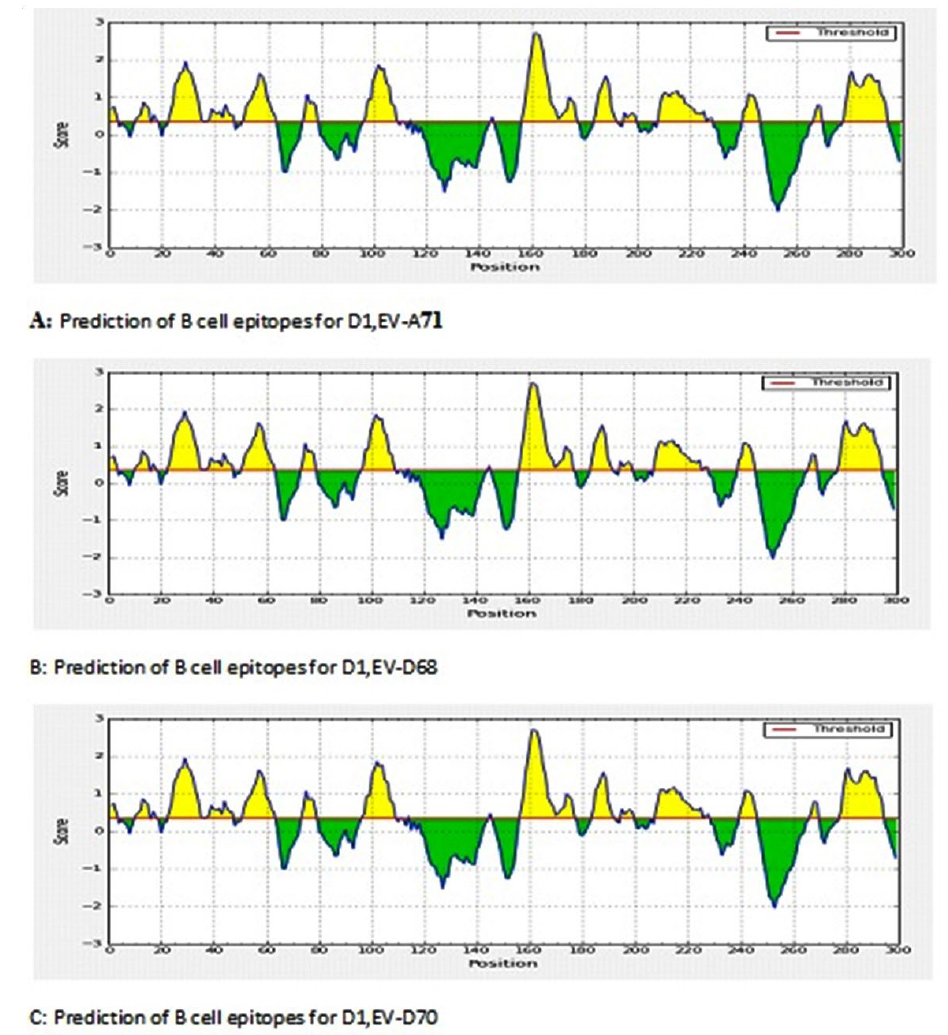
Fig. 2. Results of prediction of B linear epitopes common by HMM and ANN of the three serotypes (EV-D68, EV- D70,